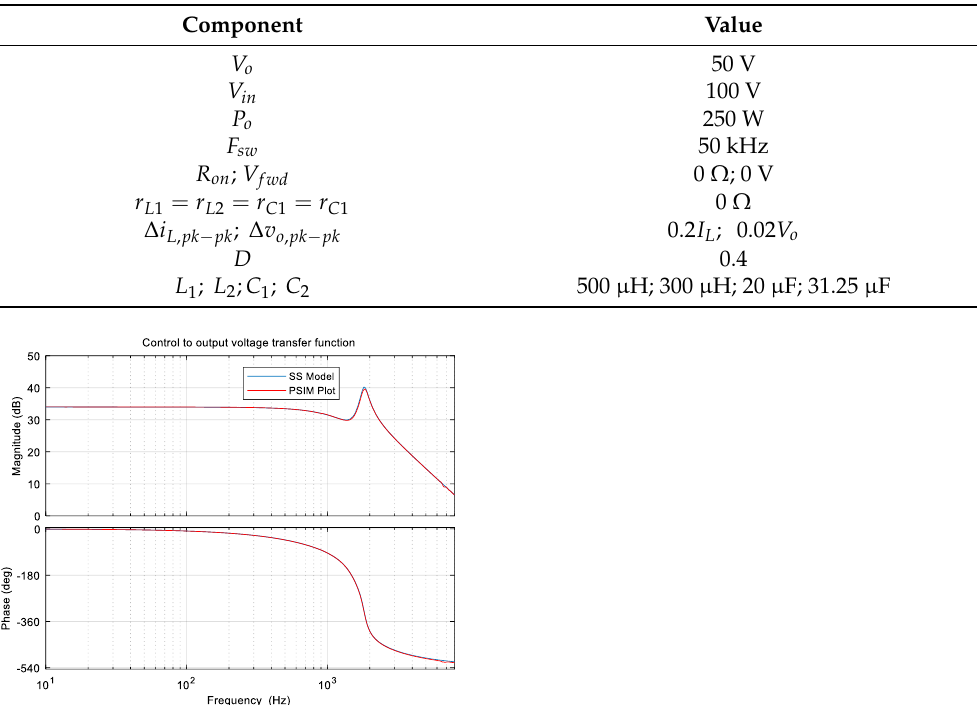
Table 6. Buck converter with input filter parameters.